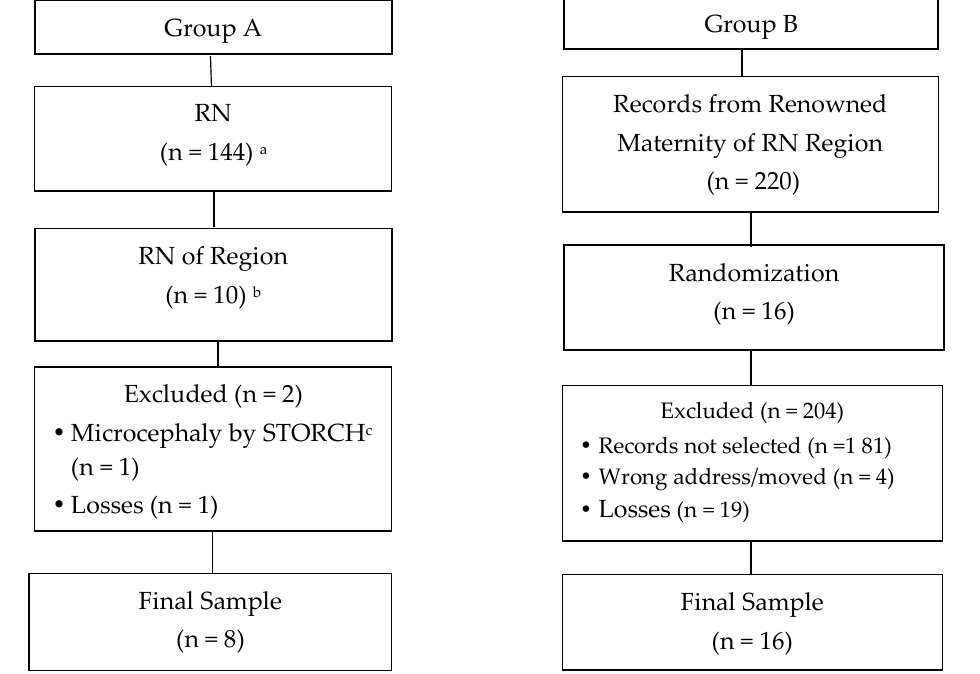
Figure 1. Flow diagram of subject recruitment for the research study. a Confirmed cases of microcephaly and/or other malformations related to congenital infections during April 2017 in State of Rio Grande do Norte of Brazil (RN). b Cases of microcephaly related to Zika virus (ZIKV). c STORCH: Syphilis, Toxoplasmosis, Rubella, Cytomegalovirus, Herpes.